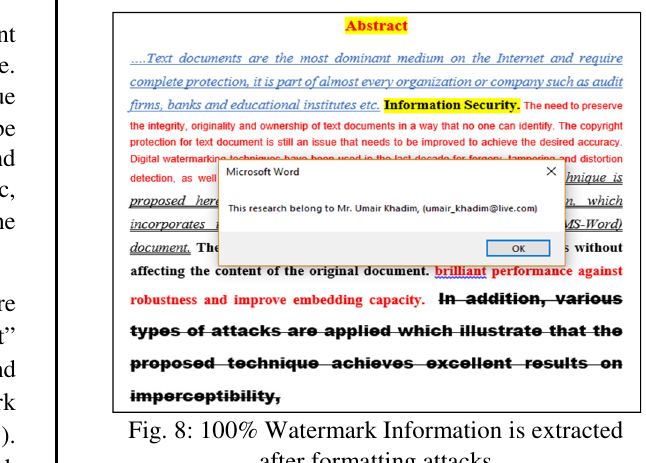
Fig. 8: 100% Watermark Information is extracted after formatting